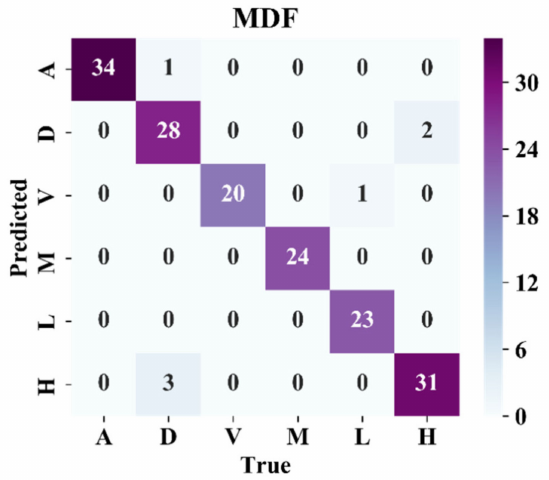
Figure 11. Confusion matrix of MDF model on the test set in the fourth